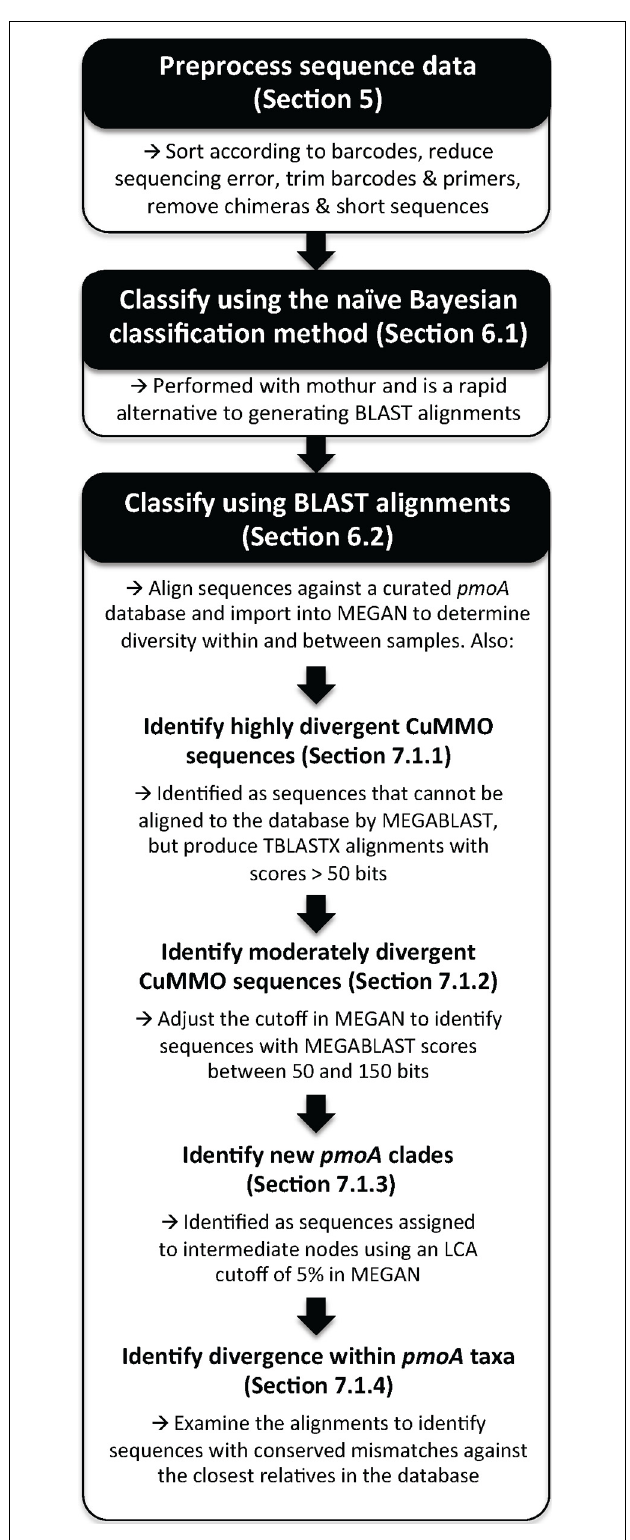
FIGURE 1 | Overview of the basic procedure for classifying pmoA sequences obtained by high-throughput sequencing. The manuscript section where a procedure is described is indicated and detailed instructions are available in the supplementary